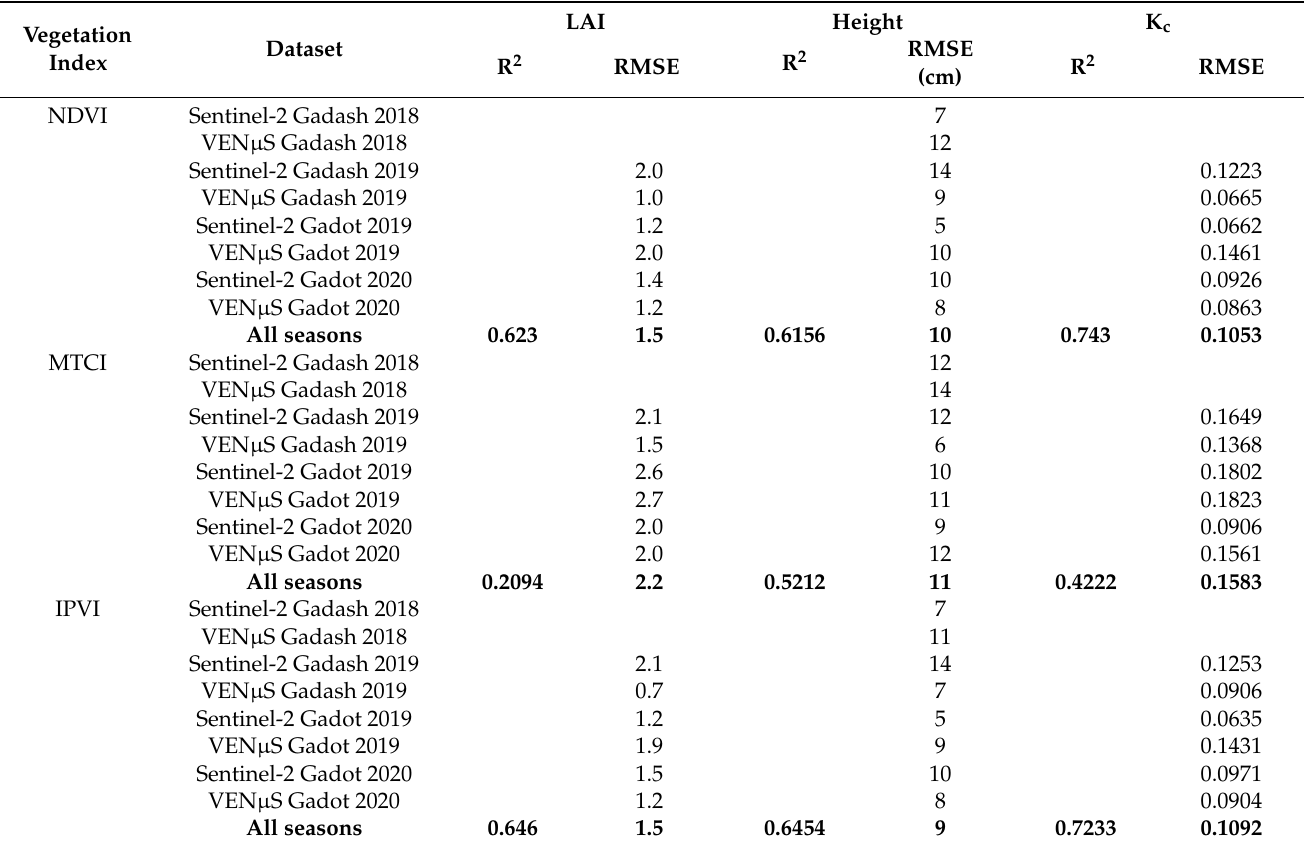
Table A4. Performance statistics of S2/V T -based LAI, Height, K c . Performance statistics of better performing VIs can be found in Table